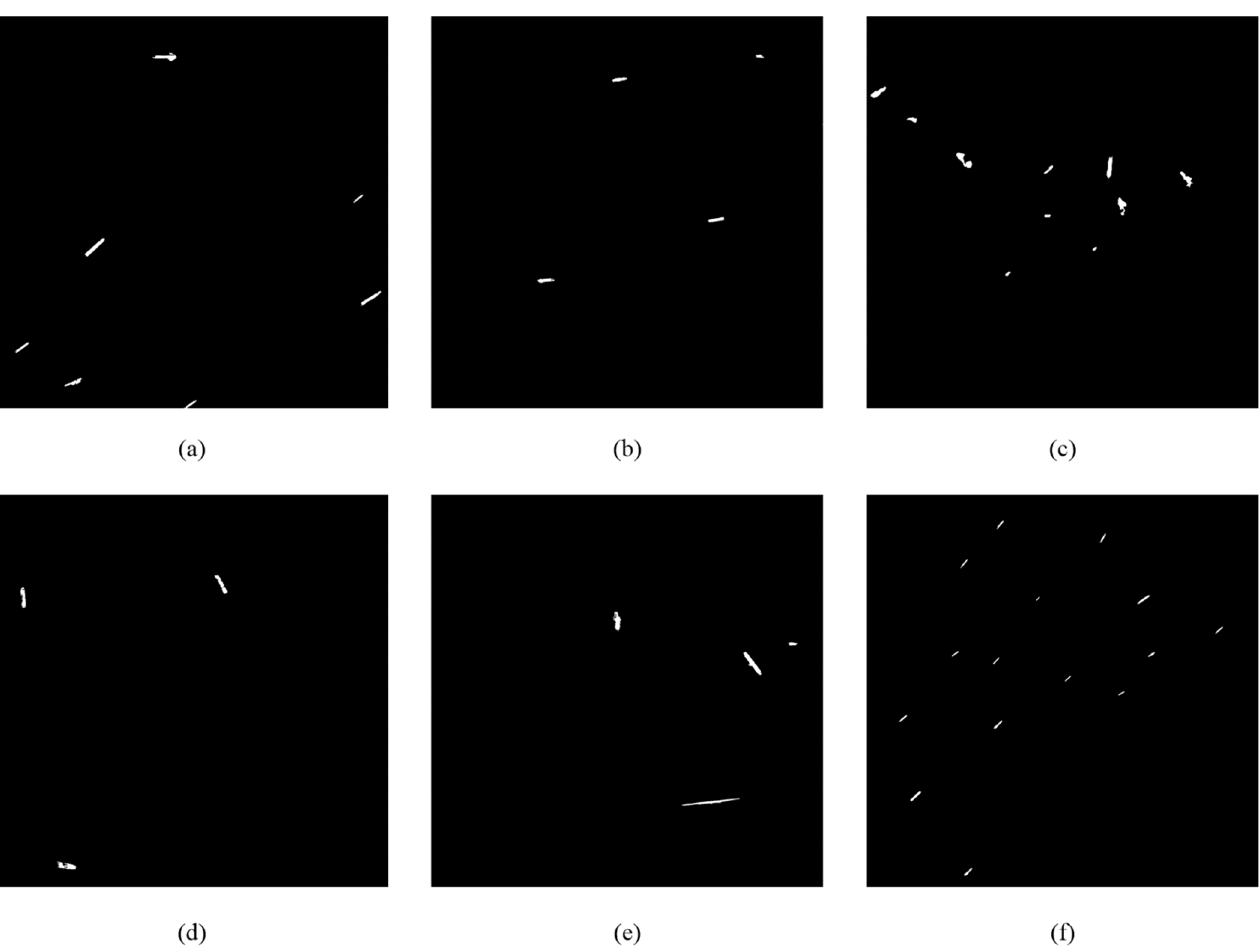
Figure 8. Target detection segmentation result image. The target superpixels are set to white, and the background superpixels are set to black. ( a – f ) are the final target segmentation results in Figure 3a–f.